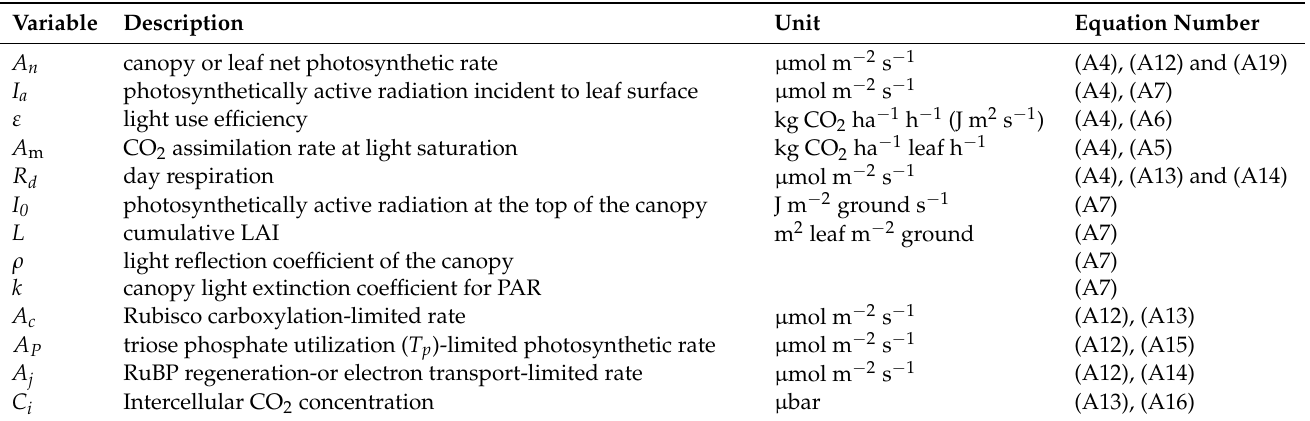
Table A1. Equation variables and